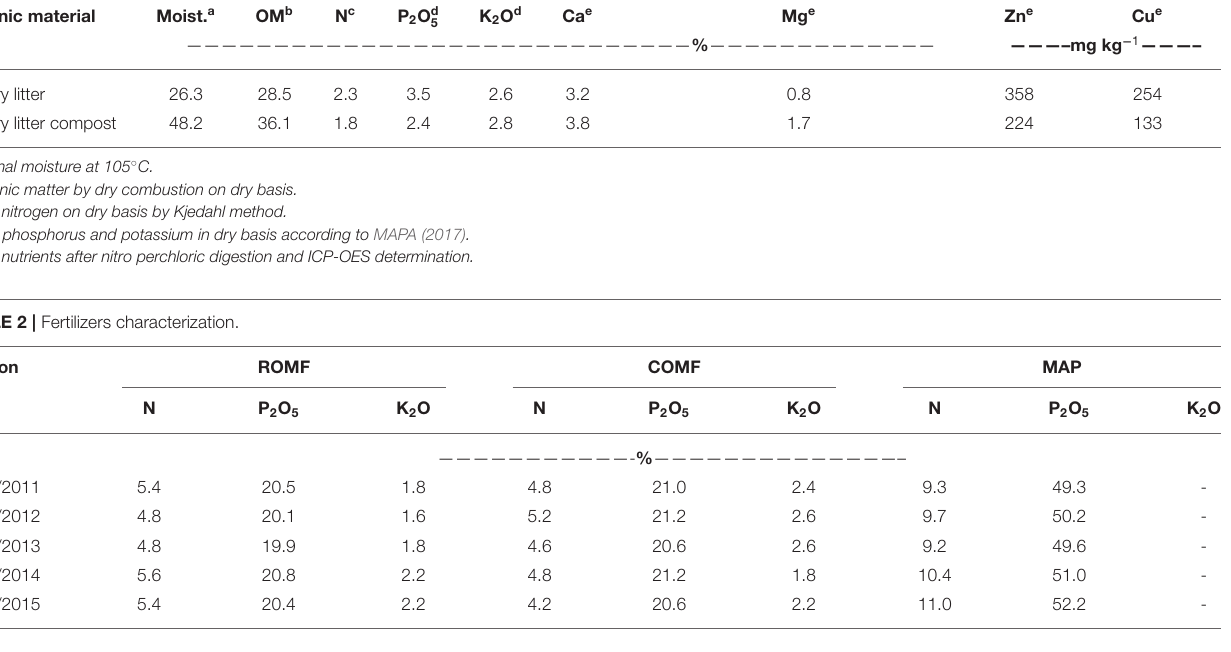
Table 3 . For 6 years before setting up the experiment, cropping during the summer season involved soybeans followed by winter fallow, which is the standard rainfed cropping practice in this